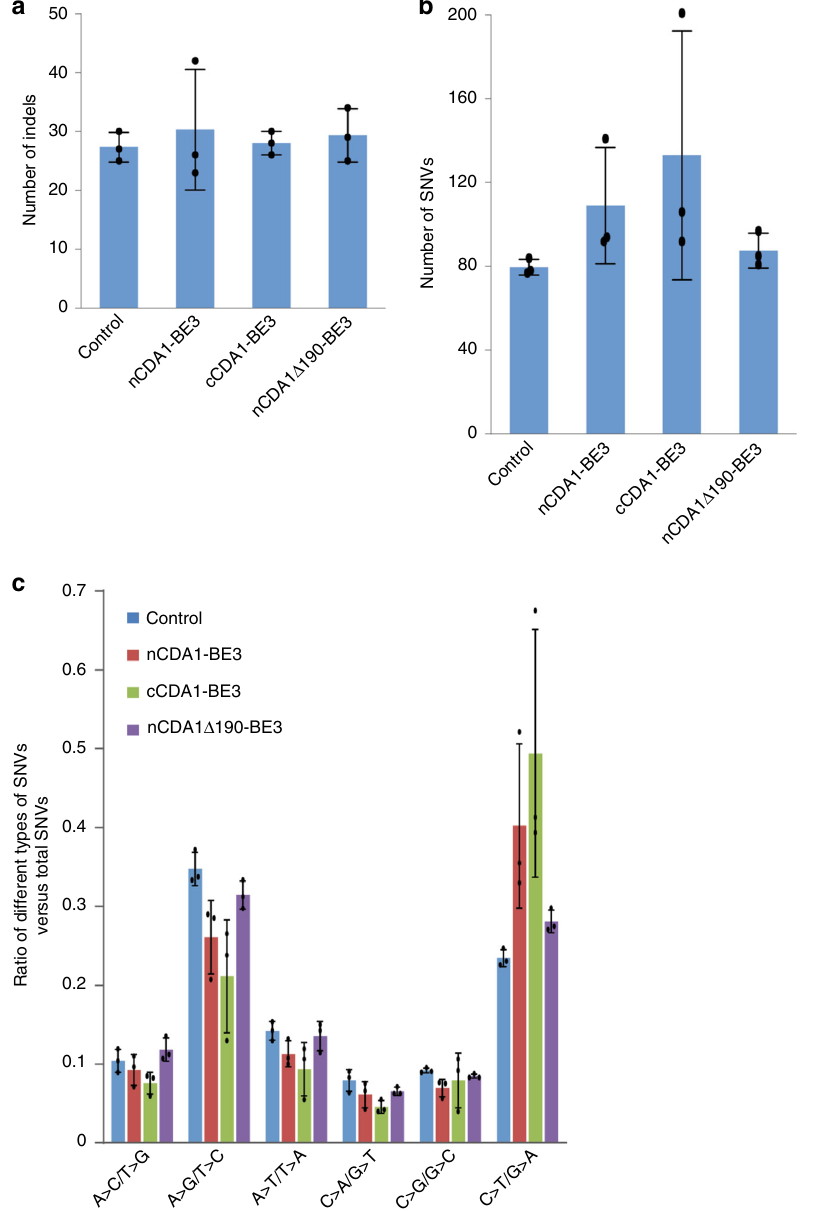
Fig. 4 Analysis of off-target editing. Genetic changes that occurred in strains harboring nCDA1-BE3, cCDA1-BE3, nCDA1 Δ 190-BE3 or a control plasmid without a BE construct were identi fi ed by whole-genome sequencing. a , b Comparison of the total number of detected indels ( a ) and SNVs ( b ). For information on the constructs used and the experimental work fl ow, see Supplementary Fig. 13. c The mutation frequency of different types of SNVs in cells treated by the three base editors and the control. The sgRNA was designed to target site Can1-4 (Supplementary Table 1). Values and error bars represent the mean and standard deviation of three independent biological replicates. Source data are provided as a Source Data fi